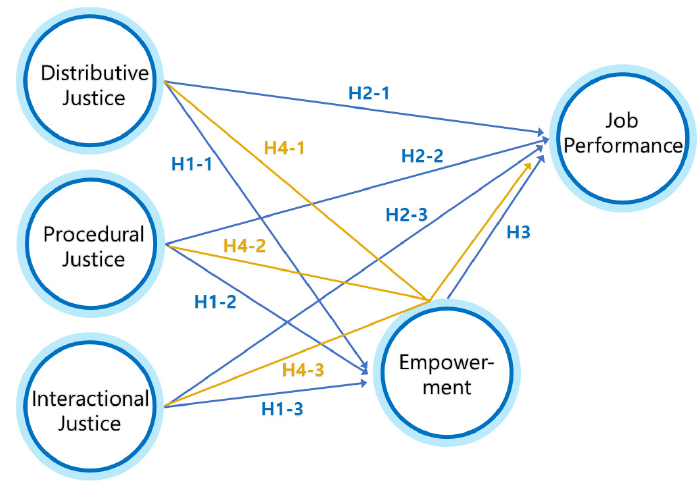
Figure 1. Proposed conceptual model .